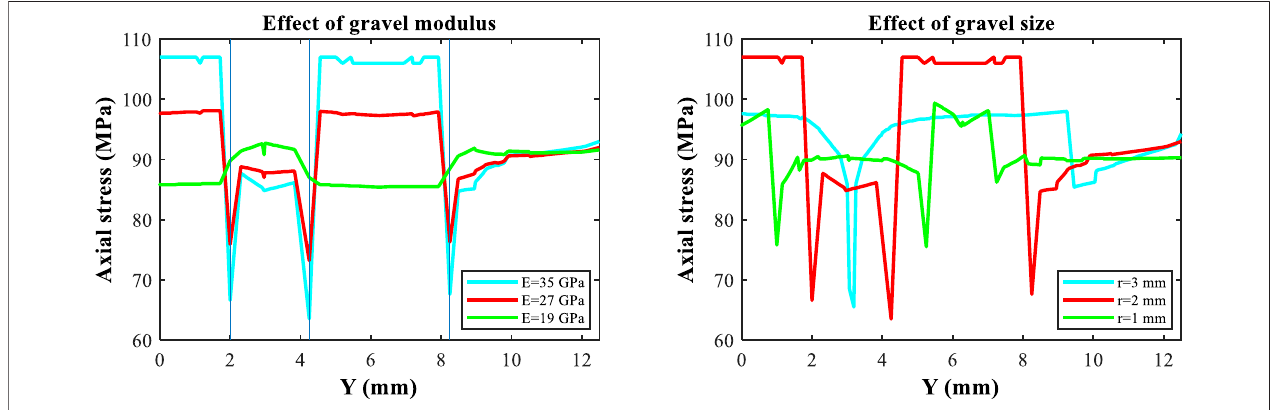
FIGURE16 | S Hmax reversal at Z (cid:2) 40 mm withvarious elastic moduliand radii ofgravels. Arrowsdenote directionsof S Hmax and red circles denote gravels. (A) E (cid:2) 35 GPa, (B) E (cid:2) 27 GPa, (C) E (cid:2) 19 GPa, (D) r (cid:2) 1 mm, (E) r (cid:2) 2 mm, and (F) r (cid:2) 3 mm.